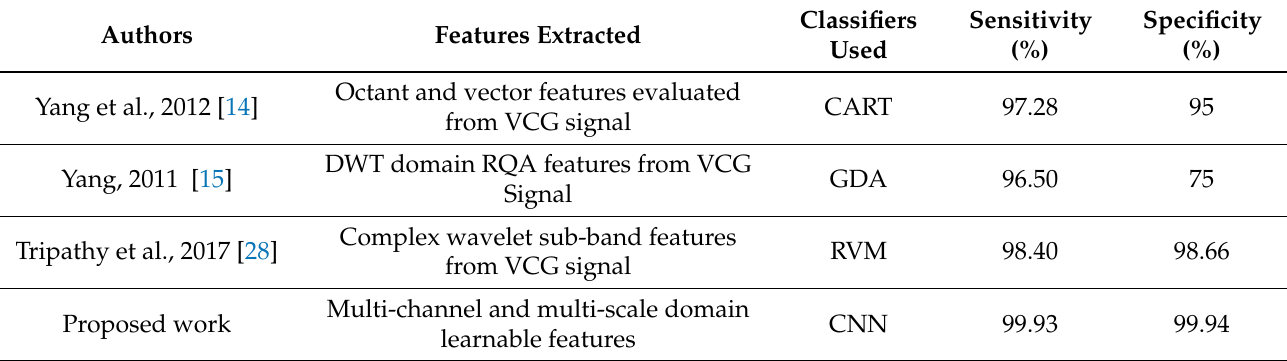
Table 12. Comparison of proposed MI detection approach with existing methods obtained using VCG signals (with 10-fold